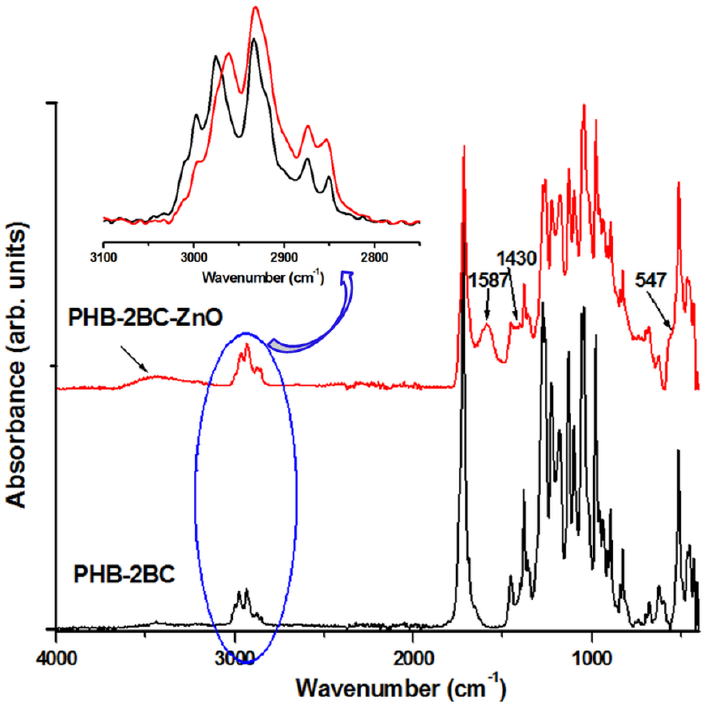
Figure 5. FTIR spectra of PHB ‒ 2BC and ZnO plasma-coated nanocomposite.